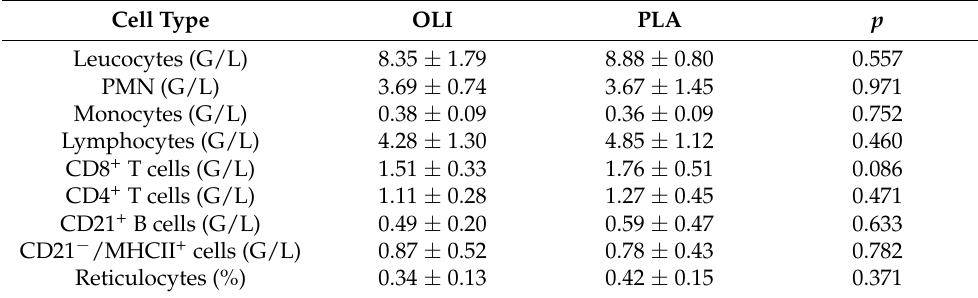
Table 3. Concentrations of blood cellular subpopulations on the day of